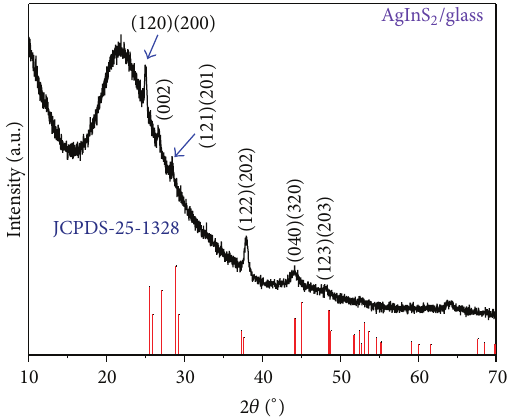
Figure 2: XRD pattern of the as-obtained glass. The JCPDS pattern of AgInS 2 crystals is also shown.